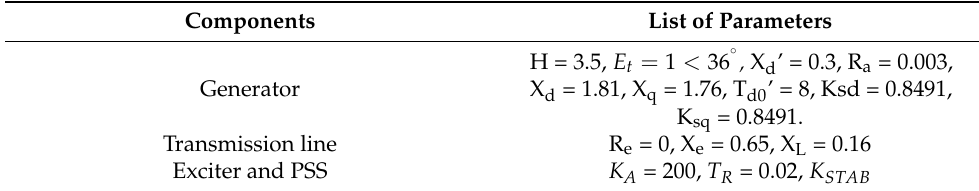
Table 2. Parameters for the SMIB and the PSS.